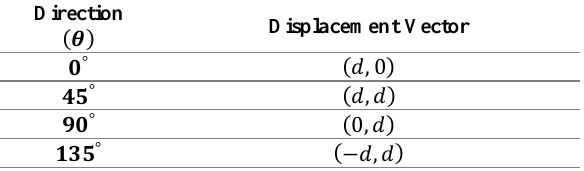
Table 1. Displacement Vectors for GLCM for 2D Data Direction (𝜽, ∅)